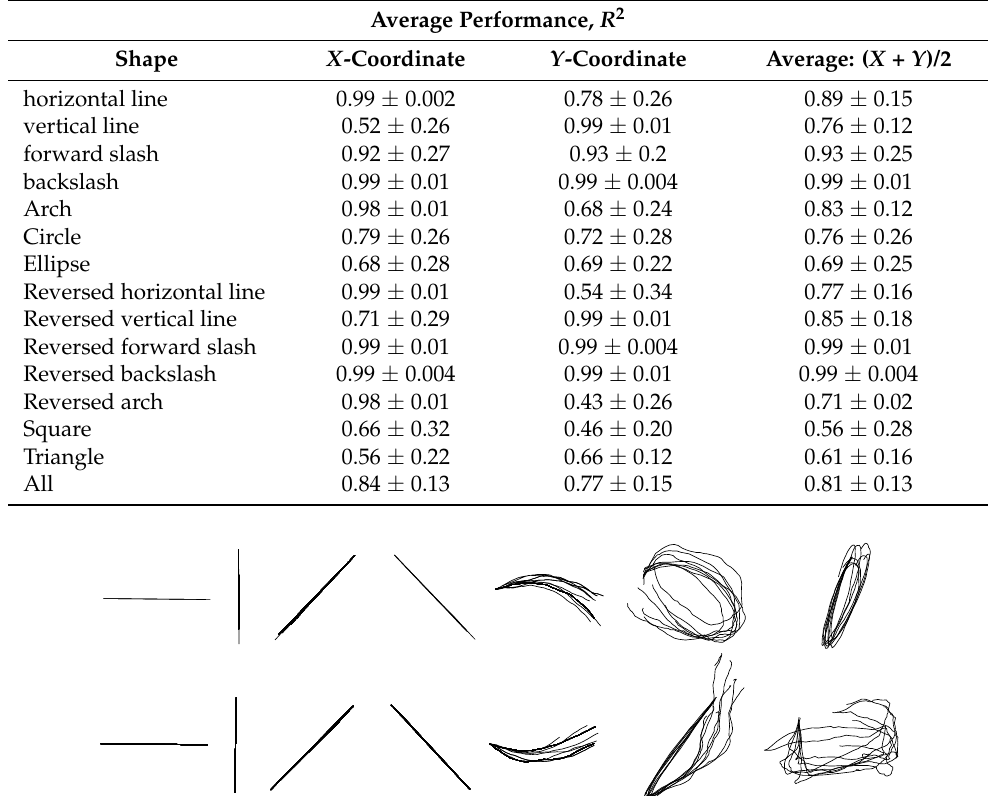
Table 4. Between-group reconstruction performance by the KF-GEP: the average accuracy of each shape across the five subjects.